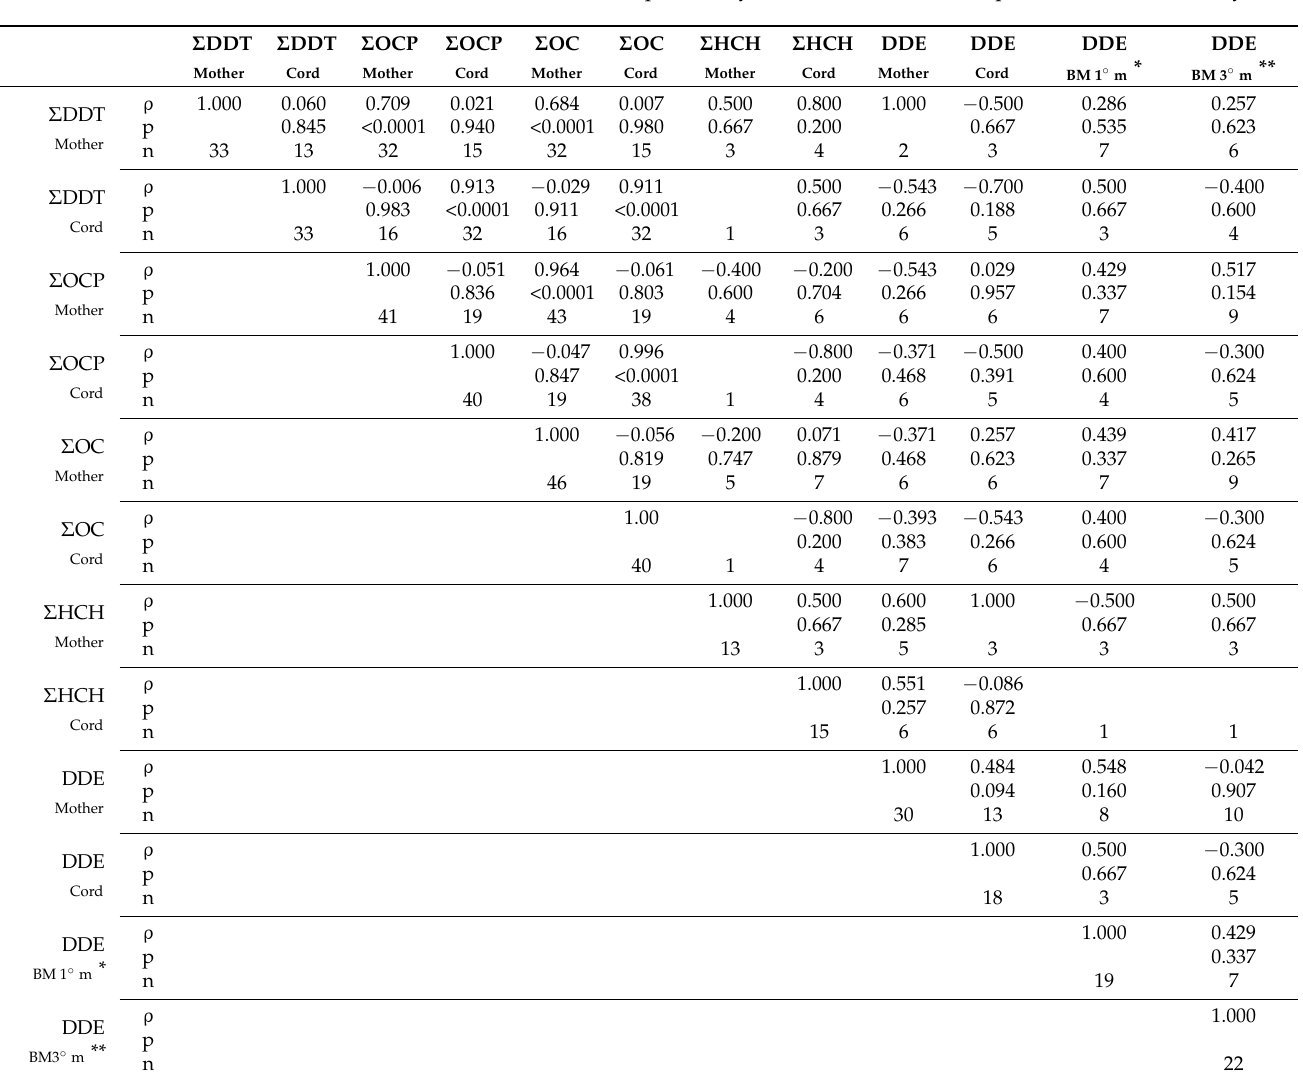
Table 4. Spearman correlation table for detected POPs concentrations in maternal and cord blood and breast milk. Rio Birth Cohort pilot study, Rio de Janeiro, Brazil, September 2017 to February